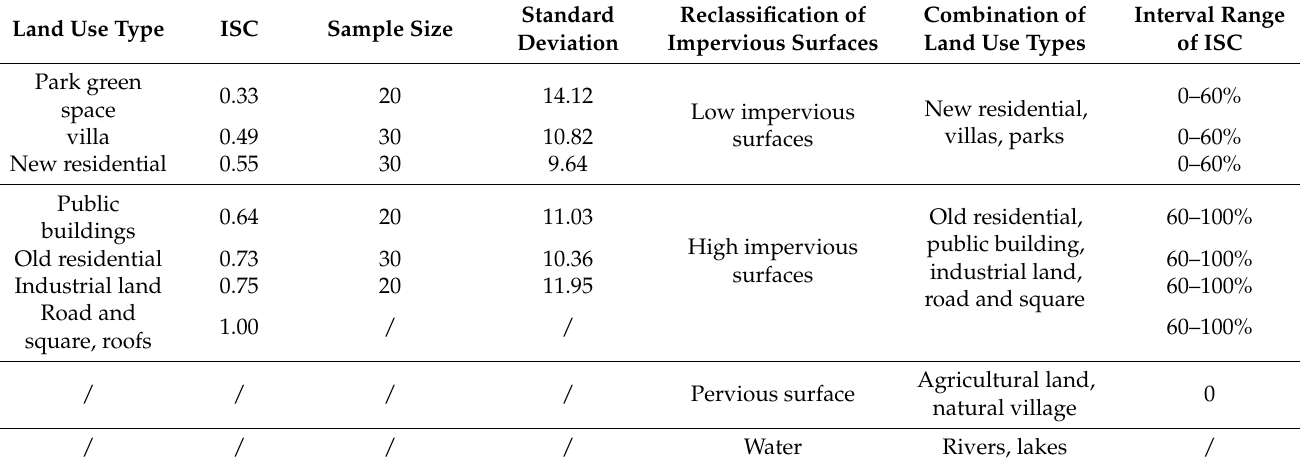
Table 1. The impervious surface and non-impervious surface coefficient of each land use type.